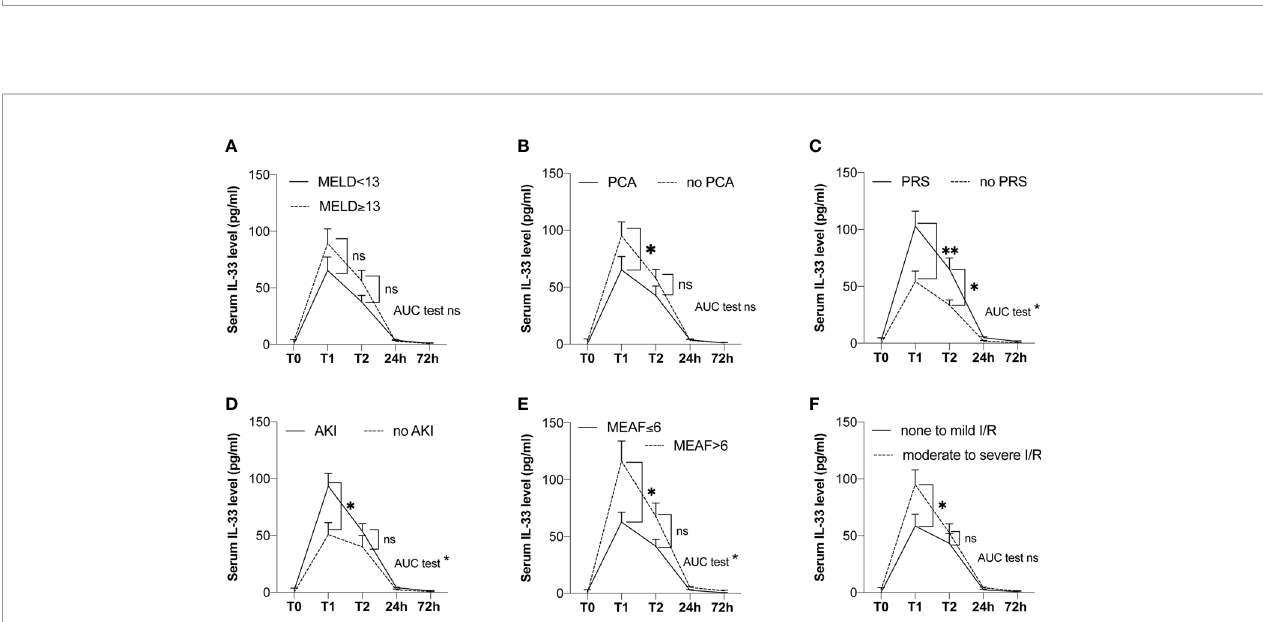
FIGURE 4 | Kinetics of serum levels of IL-33 in the peritransplant period according to groups (LT patients). (A) According to MELD score (MELD <13, n = 16; MELD ≥ 13, n = 22). (B) According to the presence of a portocaval anastomosis (yes, n = 18; no, n = 20). (C) According to the occurrence of a postreperfusion syndrome (yes, n = 19; no, n = 21). (D) According to the occurrence of acute kidney injury (yes, n = 25; no, n = 15). (E) According to MEAF (MEAF ≤ 6, n = 29; MEAF >6, n = 11). (F) According to tissue lesions of I/R (none to mild lesions, n = 18; moderate to severe lesions, n = 21). T0: before LT, T1: immediately after reperfusion, T2: at the end of liver transplantation. AKI, acute kidney injury; MELD, model for end-stage liver disease; PCA, anastomosis; PRS, postreperfusion syndrome. Data are expressed as means ± SEM. ns, not signi fi cant; * p < 0.05; ** p < 0.001. Mann-Whitney U test was